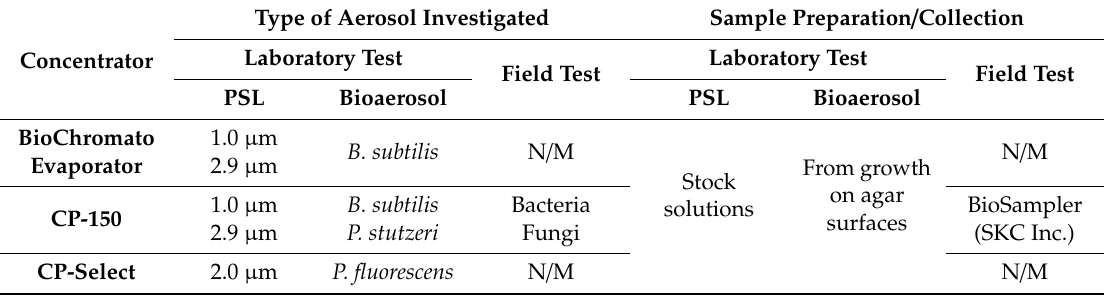
Table 1. Type of aerosol investigated and the method for sample preparation / collection when concentrating the samples using